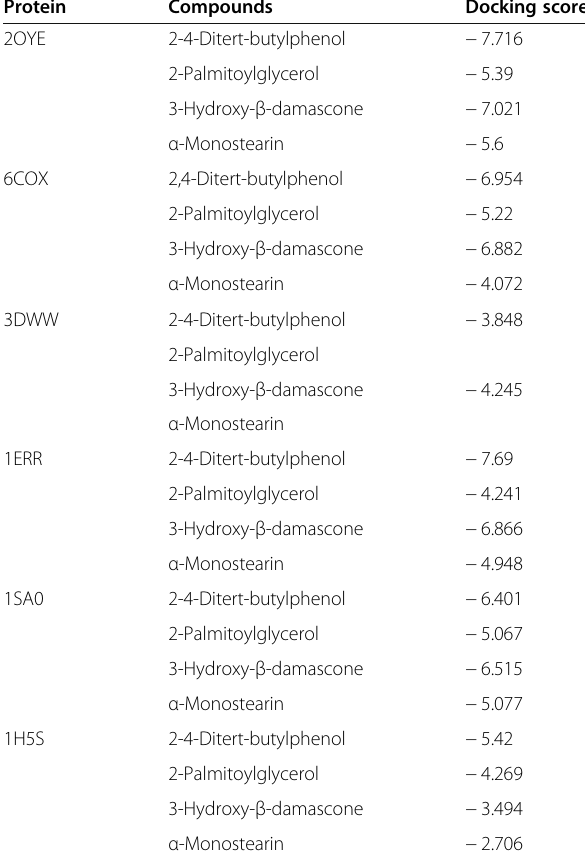
Table 3 Molecular docking score of isolated compounds from A.